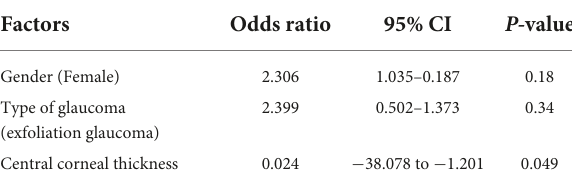
TABLE 3 Multivariate analysis of factors associated with